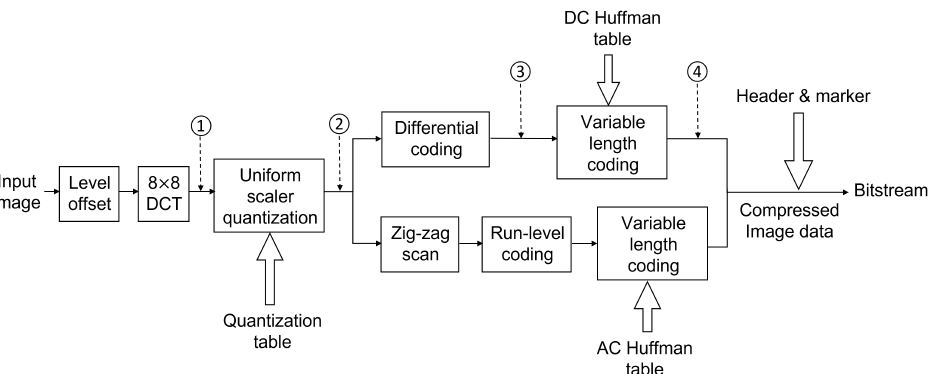
Figure 3. Flow chart for baseline JPEG for the grayscale image. An input image will go through multiple operations, including DCT, quantization, differential coding, and variable-length coding. The output is bitstream with headers and markers containing side information for the decoder. Numbers 1 to 4 denote the locations where we extract datasets 1 to